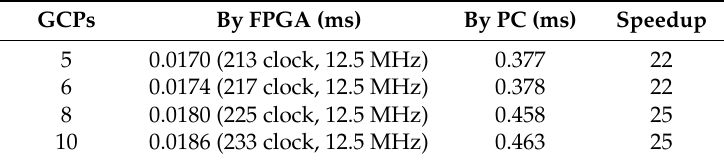
Table 7. The FPGA-based computational time under different numbers of GCPS.